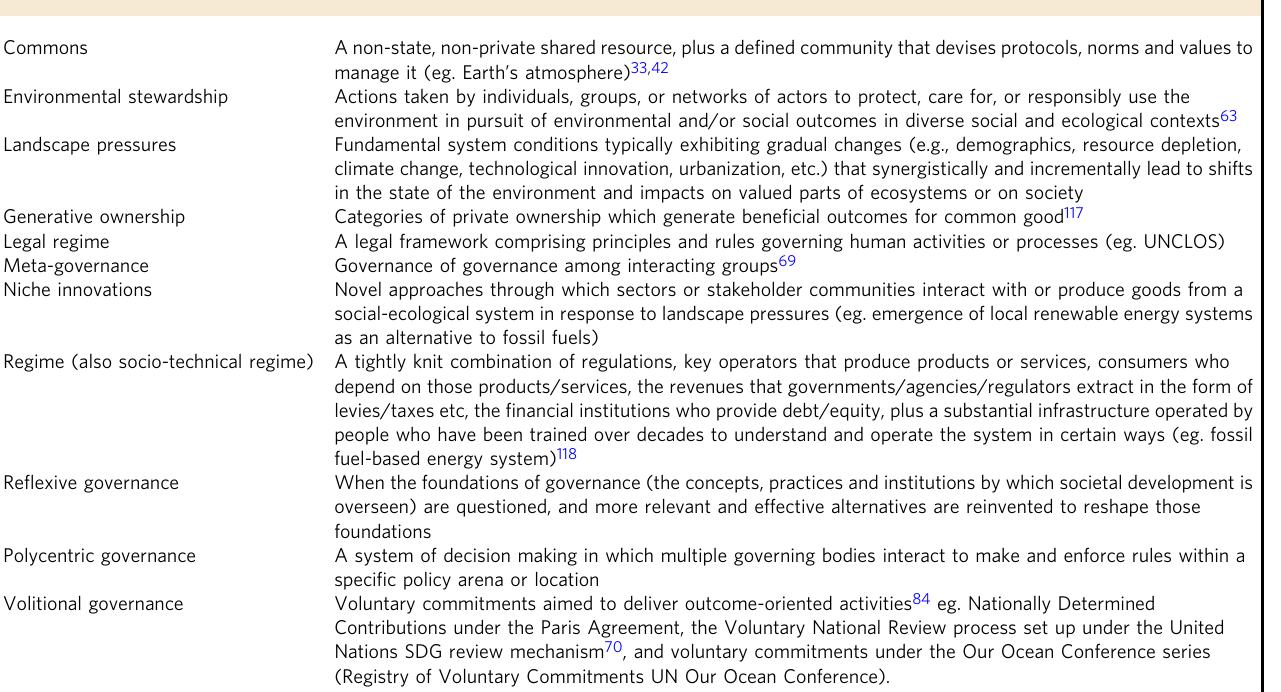
Table 1 Glossary of